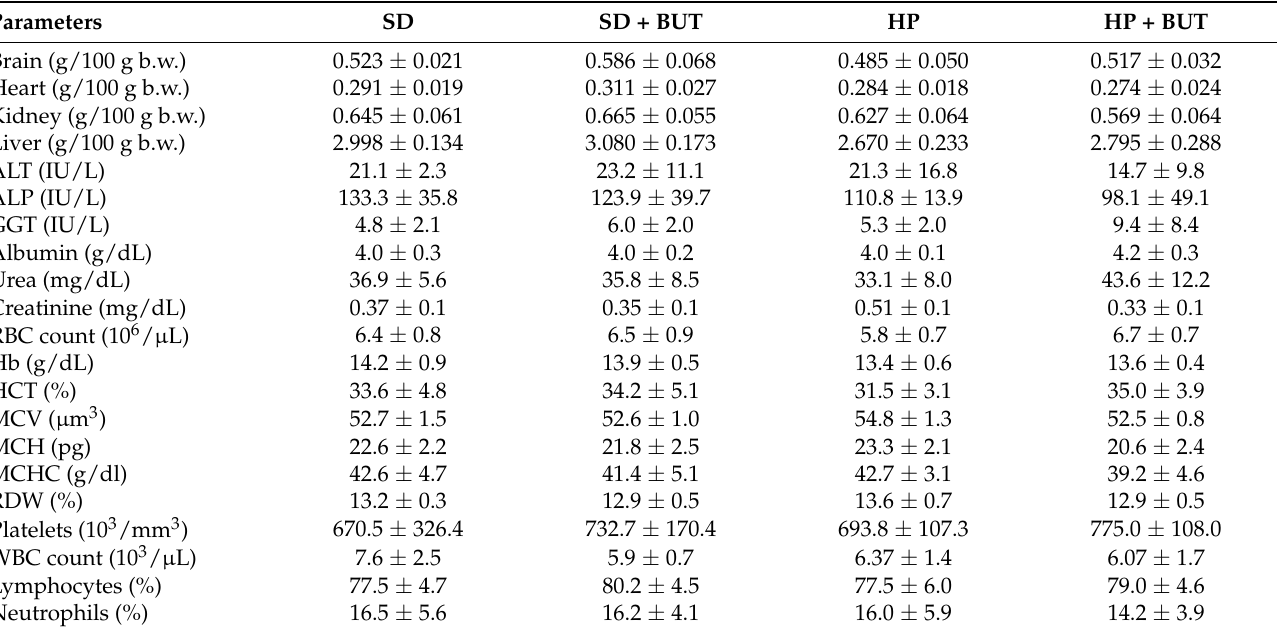
Table 1. Effects of different diets and the C. baccatum BUT extract (200 mg/kg, per os) on the relative weight of visceral organs (g/100 g b.w.), the serum biochemical parameters, and the hematological profile after a 130-day study in